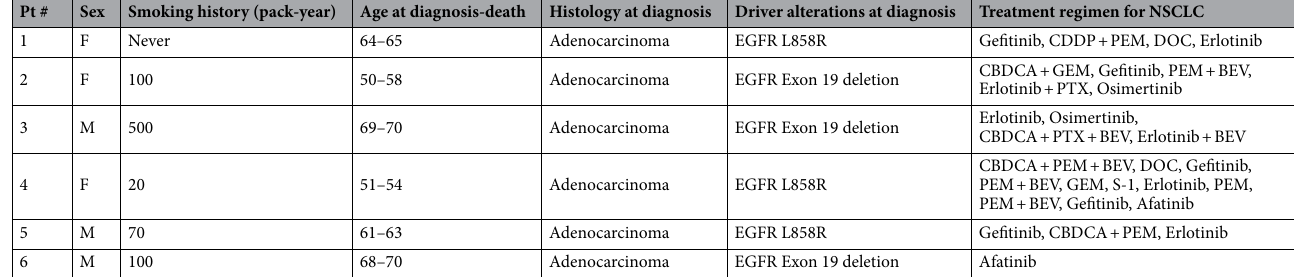
Table 1. Patient characteristics. Pt patient, M male, F female, NSCLC non-small cell lung cancer, CDDP Cisplatin, PEM Pemetrexed, DOC Docetaxel, CBDCA Carboplatin, GEM Gemcitabine, BEV Bevacizumab, PTX